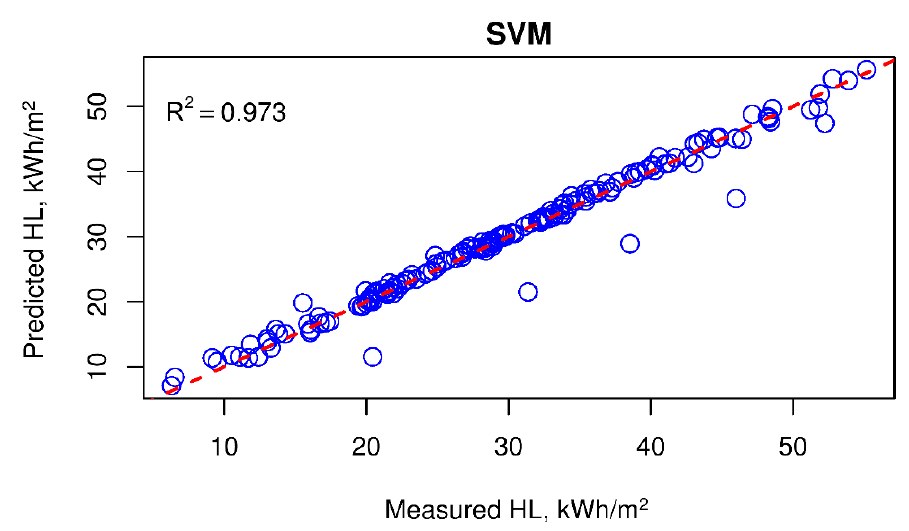
Figure 12. The results of HL prediction from the XGBoost model.